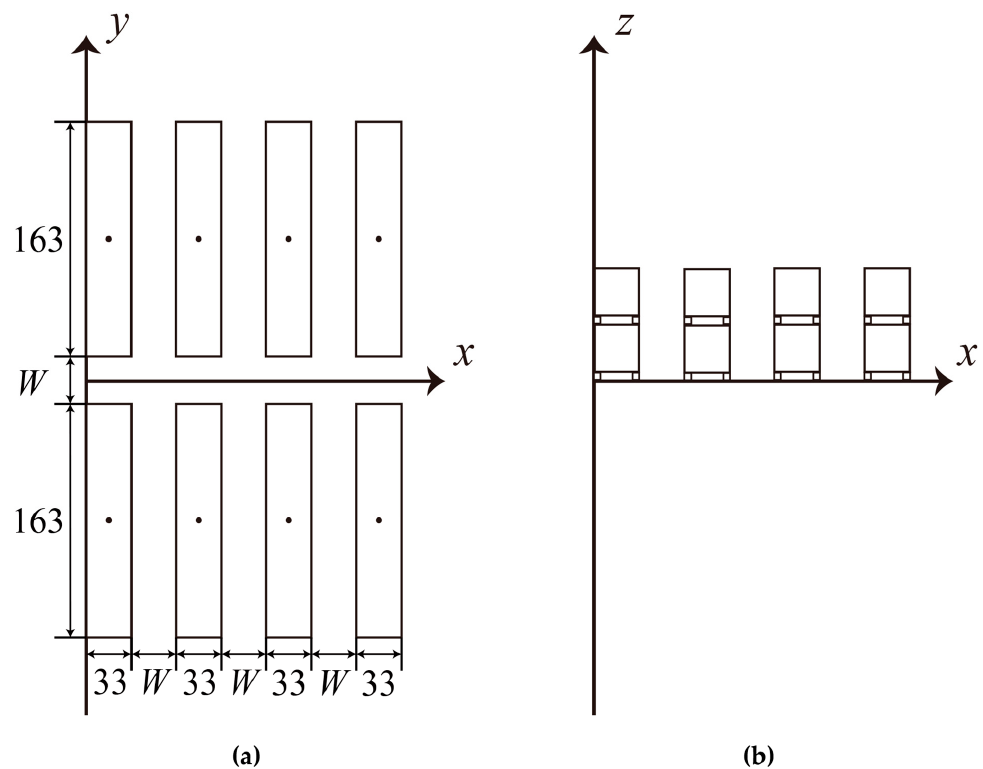
Figure 6 . Initial configuration debris for numerical simulation Configuration 42290: ( a ) top view; ( b ) side view (unit: mm). Table 1. Numerical simulation